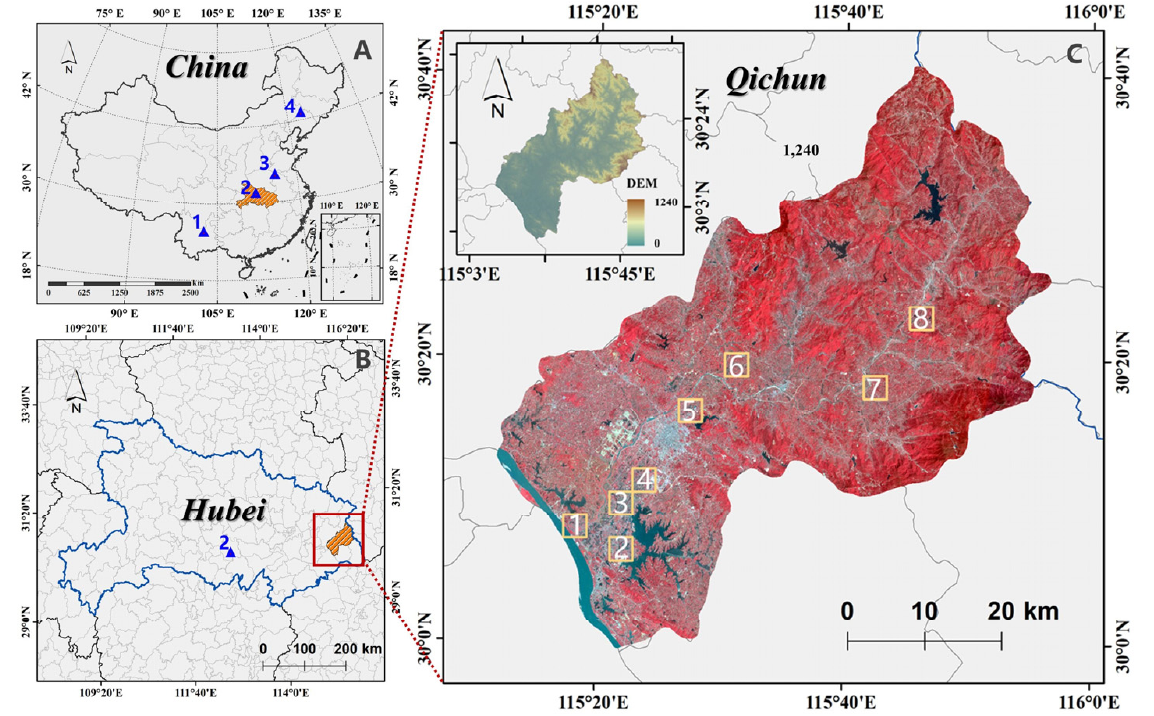
Figure 1. The spatial location of the selected test regions used for the cropland parcel extraction and the other four regions for evaluating the transferability of the MSAOS. ( A ) is the spatial distribution of the test region (orange area) and the evaluation tiles (four blue triangles); ( B ) details the geographic location of test region and the evaluation tile in Hubei province; The top-left inset and large pictures in panel ( C ) refer to a digital elevation map (DEM) and pseudo-color (RGB: near-infrared, red, and green) image of Qichun, respectively. The squares with yellow solid lines in panel ( C ) are the selected test tiles used to evaluate the MSAOS performance.